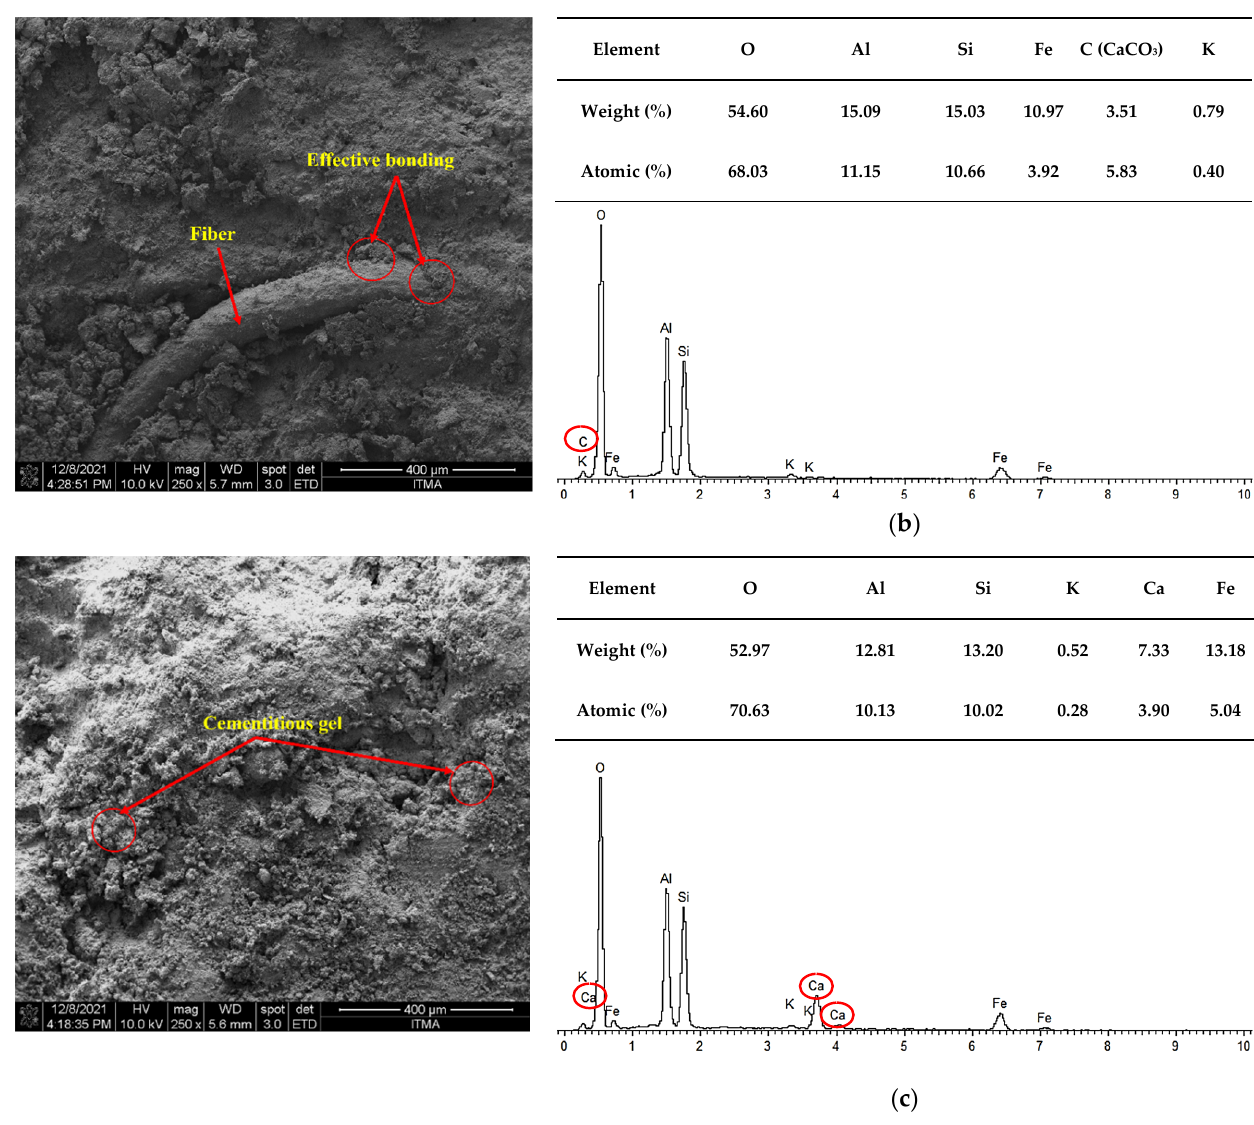
Figure 12. FESEM images of ( a ) lateritic soil, ( b ) AC specimen, and ( c ) lime specimen.